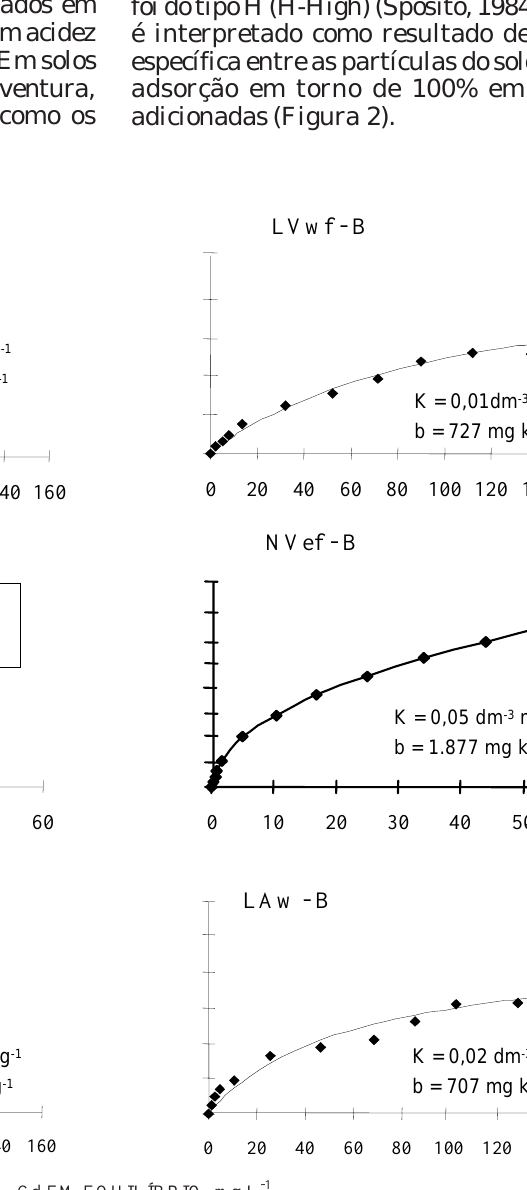
Figura 2. Isotemas de adsorção de cádmio nos horizontes A e B dos solos estudados. (K = constante de afinidade; b = adsorção máxima; NVef = Nitossolo Vermelho eutroférrico; LVwf = Latossolo Vermelho acriférrico; Law = Latossolo Amarelo